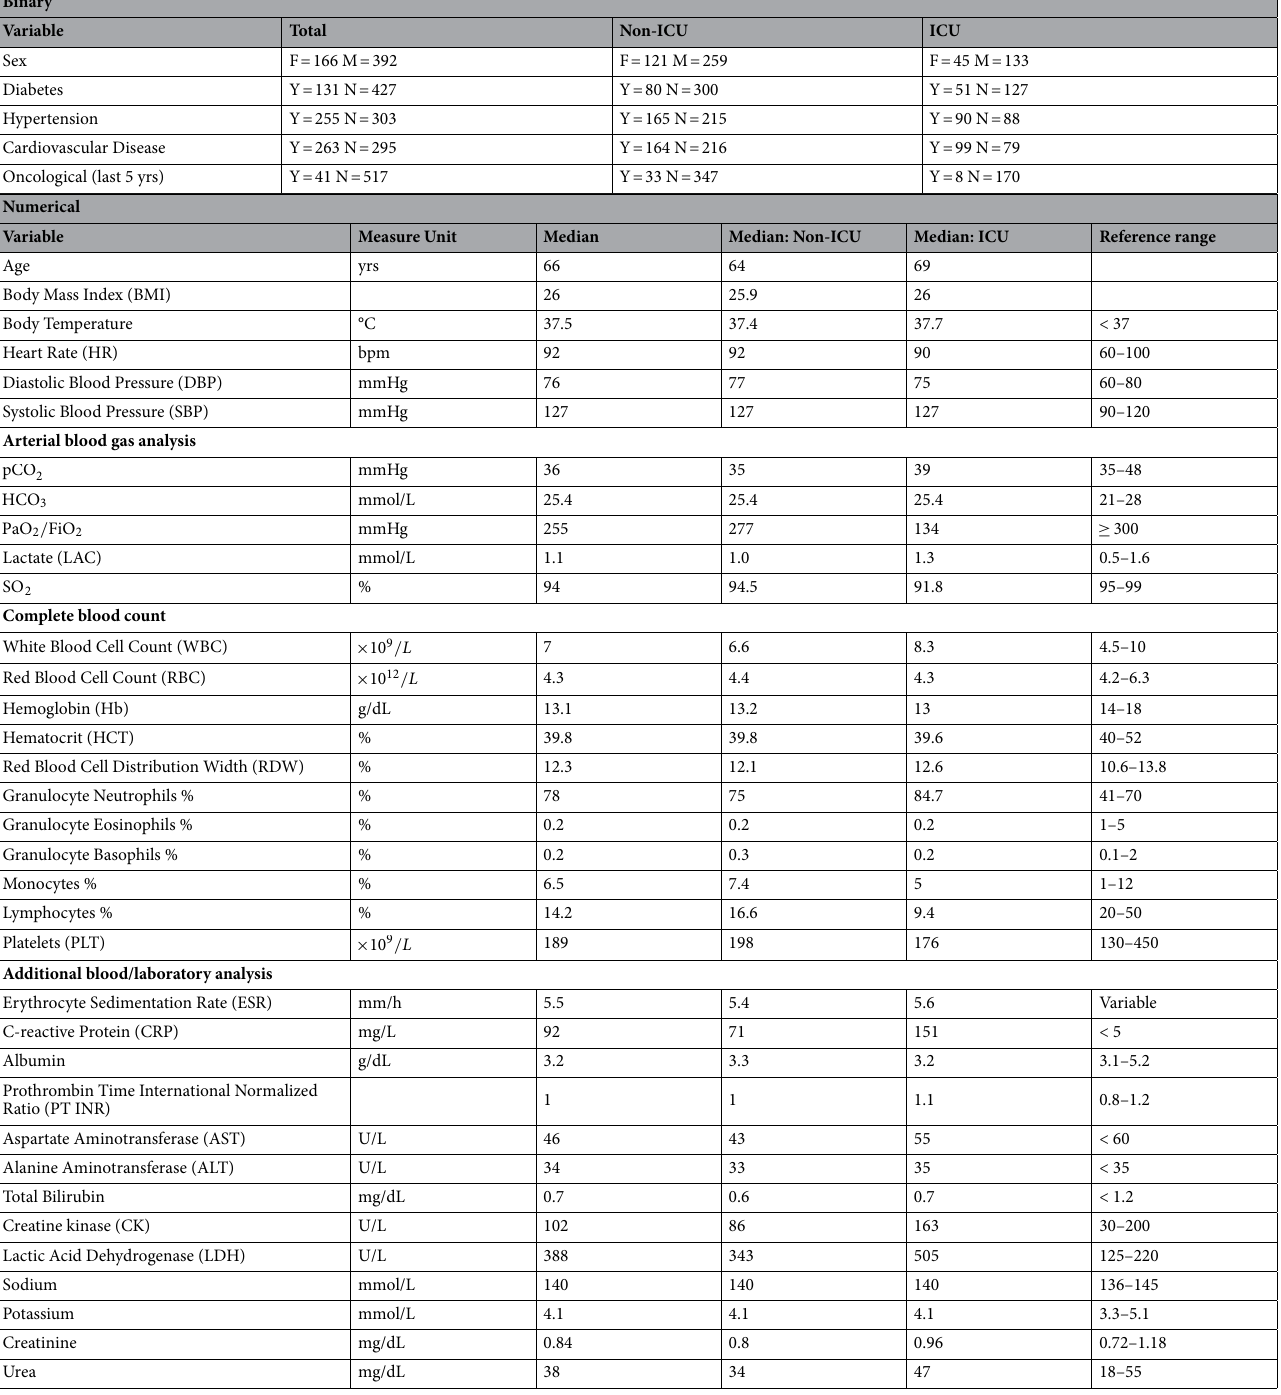
Table 1. Summary of clinical and laboratory variables